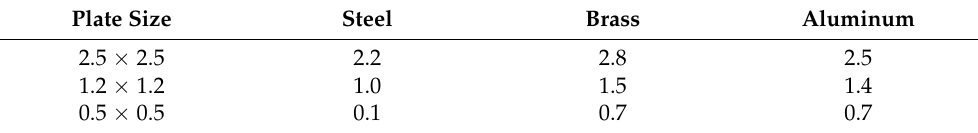
Table 2. Detection distances for plates of different metals and sizes in terms of sensitive coils diameter. Plate Size Steel Brass